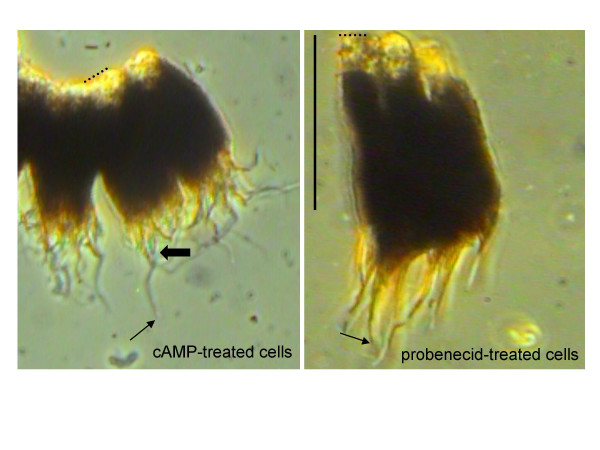
RPE cells with pigment aggregated and dispersed. Phase contrast images illustrate RPE with pigment granules aggregated in response to treatment with 1 mM cAMP (left) and RPE with pigment granules dispersed as a consequence of inhibition of cAMP-induced aggregation by probenecid (0.5 mM; right). Dotted lines indicate the position of the base of the cell, and the thin, diagonal arrow indicates the position of the end of the longest apical process for the same cell. For the cAMP-treated cells, a thick, horizontal arrow indicates the position of the distal-most pigment granule; for the probenecid-treated cells, that position corresponds with the end of the process. Scale bar equals 50 μm.